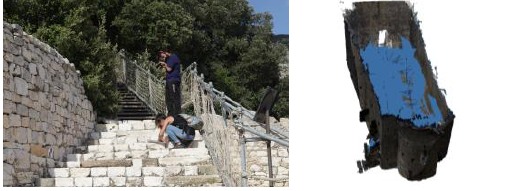
Figure 10. CRP acquisition phases (left) and example of the processed data (right)